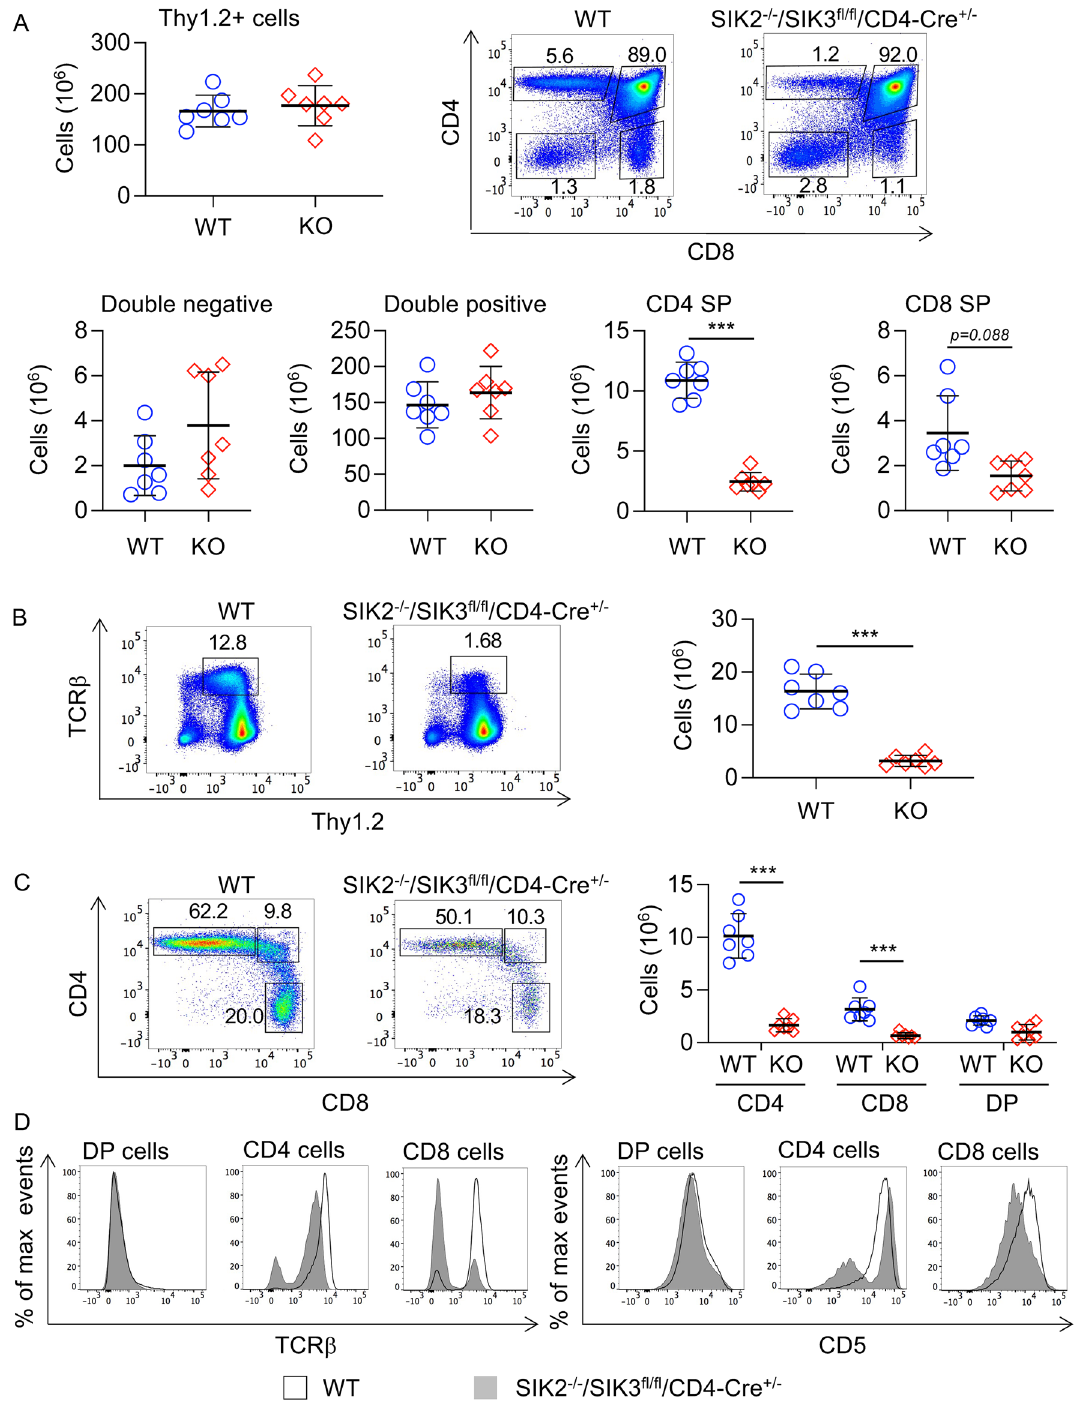
Figure 8. Transition to CD4 and CD8 SP cells is reduced in SIK2 −/− /SIK3 fl/fl /CD4-Cre +/− mice. Thymi were isolated from wild type (WT) and SIK2 -/- /SIK3 fl/fl /CD4-Cre +/- (KO) mice and analysed by flow cytometry. The number of Thy1.2 +ve cells in the thymus along with representative CD4/CD8 plots and numbers of DN, DP and SP cells is shown in ( A ). Thymocytes were also analysed for expression of cell surface TCRβ. Representative plots of Thy1.2 vs TCRβ in live thymocytes along with quantification of TCRβ high cells is shown in ( B ). Analysis of CD4 and CD8 expression in the TCRβ high cells is shown in ( C ). Representative histograms for cell surface expression of TCRβ and CD5 in DP, CD4 and CD8 SP cells are shown in ( D ). Graphs show mean with symbols representing measurements from individual mice. Differences in cell number between wild type and knockout mice were analysed by two tailed Student’s t-test ( A , B ) or two way ANOVA with Sidak’s post hoc testing. p < 0.05 is indicated by *, < 0.01 by ** and < 0.001 by ***. Graphs show data for 7 mice per